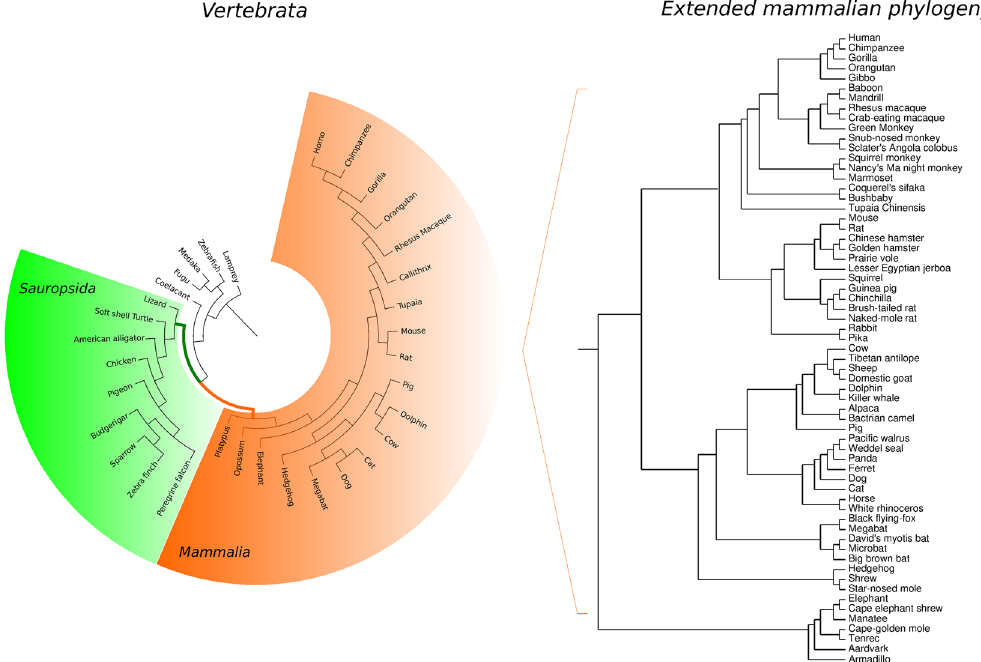
Figure 2. Vertebrata and mammalian phylogenies. Phylogenetic tree of the Vertebrata species used in our analyses. The mammalian and sauropsidan branches are highlighted in orange and green, respectively. The extended mammalian phylogeny is also reported on the right (Supplementary Table